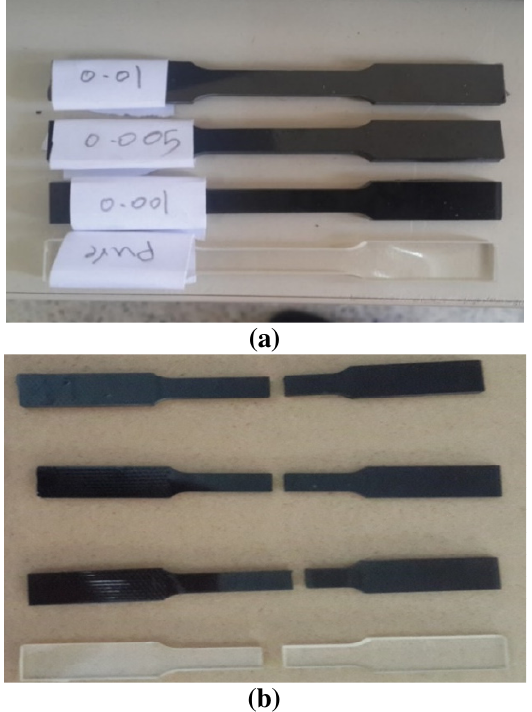
Fig. 5. Tensile test specimens according to ASTM D638, (a) before tests, (b) fractured